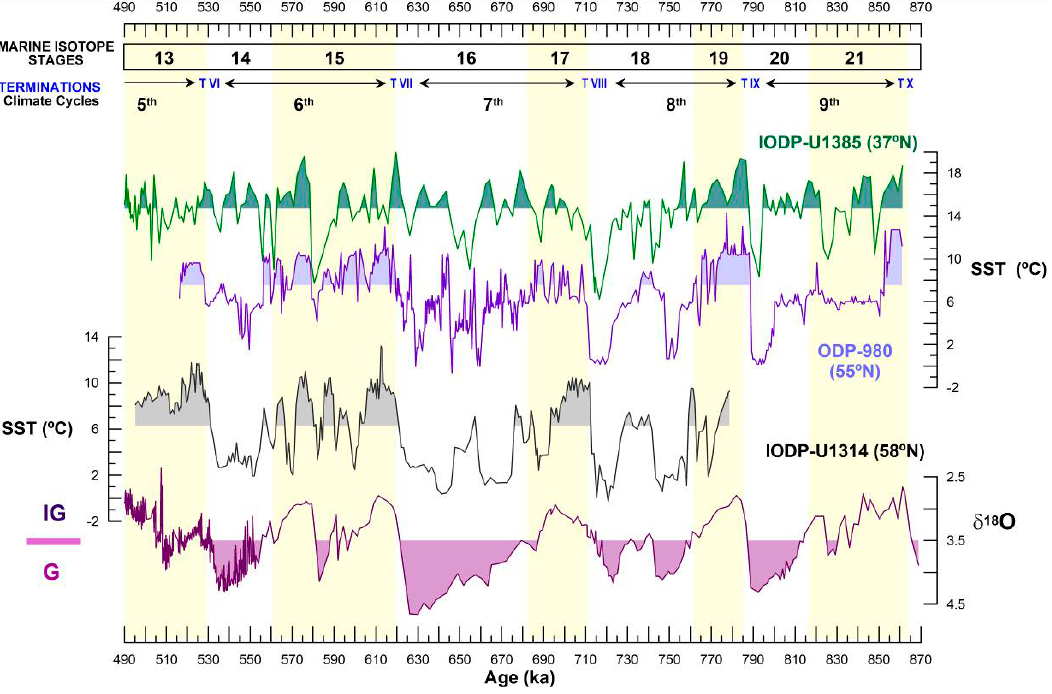
Figure 7. Latitudinal SST gradient in the North Atlantic between subpolar sites IODP-U1314 [78], ODP-980 [36], and the subtropical site IODP-U1385 [60] through middle Pleistocene climate cycles. Filled-in SST records highlight temperature above average for each site. Yellow bands highlight interglacial periods. The ice volume is indicated by δ 18 O [79]; purple fill shows the ice volume threshold separating glacial and interglacial stages. Marine isotope stages, terminations (in roman numerals), and climate cycles are represented on top. Yellow bands highlight interglacial stages. After the ice-sheet-collapse events had finished and the input of very cold, low-salinity water stopped, the AF retreated northward again. The subtropical gyre rapidly resumed, and the